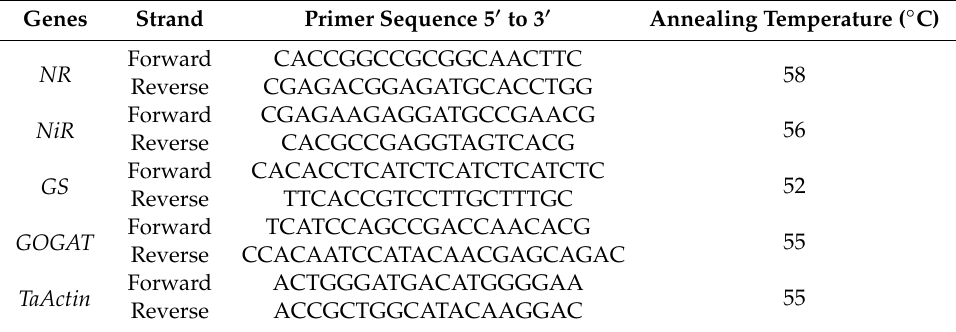
Table 5. Sequences of primers used for qRT-PCR of NR, NiR, GS, and GOGAT